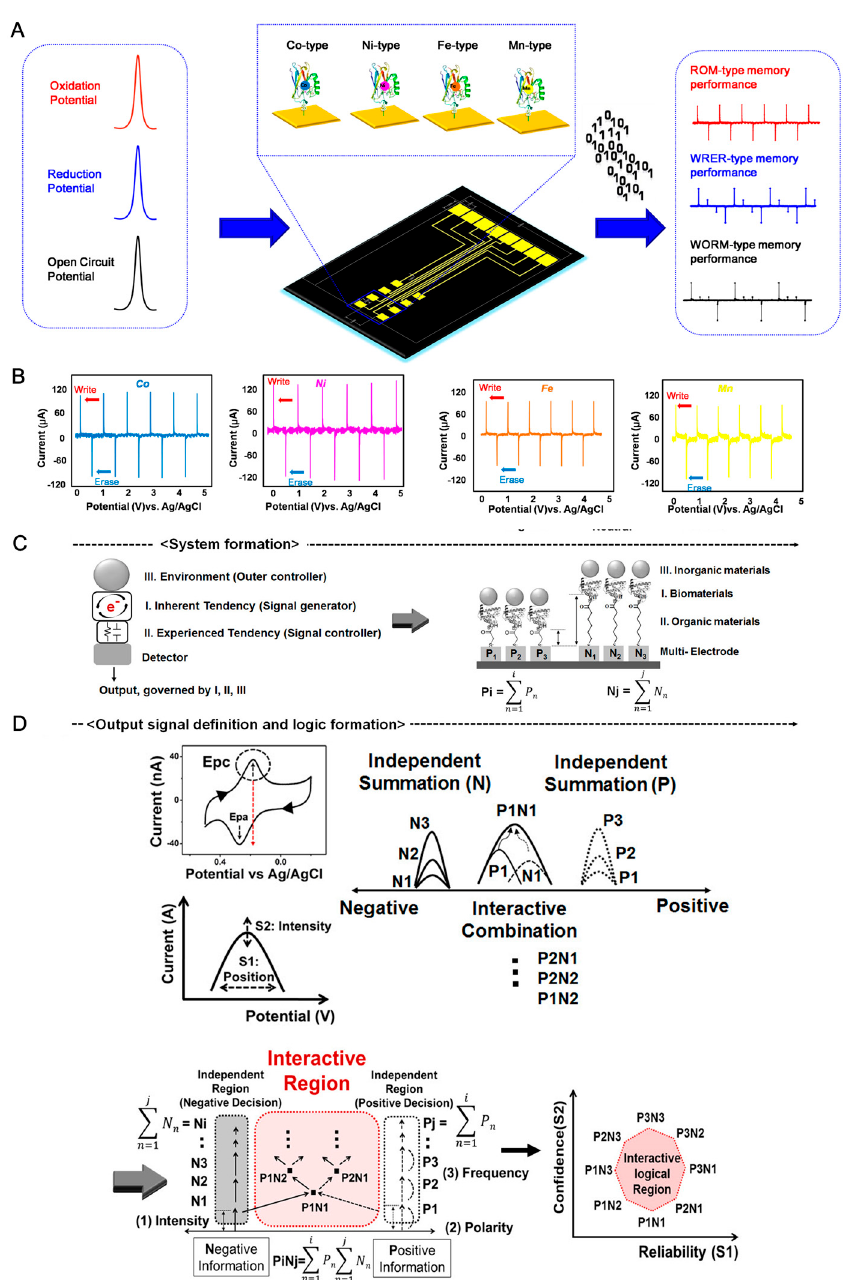
Figure 4. ( A ) Schematic diagram of the basic operating mechanism of the fabricated biomemory chip. Reproduced with permission from [95], published by Elsevier, 2010. ( B ) Verification of the two-state charge storage function by chronoamperometry. Blue line: Co-type azurin, Pink line: Ni-type azurin, Brown line: Fe-type azurin, Yellow line: Mn-type azurin. The figure displays the corresponding currents were observed when assigned to oxidation potential and reduction potential repeatedly for a total duration of 5 s. Reproduced with permission from [95], published by Elsevier, 2010. ( C ) Formation of bio-hybrid materials for the realization of proposed concept (left), specific device structure as a hardware-type platform for logic operations (right) [87], the figure has followed the terms of use under functions using output results (left), demonstration of defined regions (independent and interactive) using controlled electrochemical signal of metalloprotein (right) [87], the figure has followed the terms of use under a Creative Commons Attribution 4.0 International